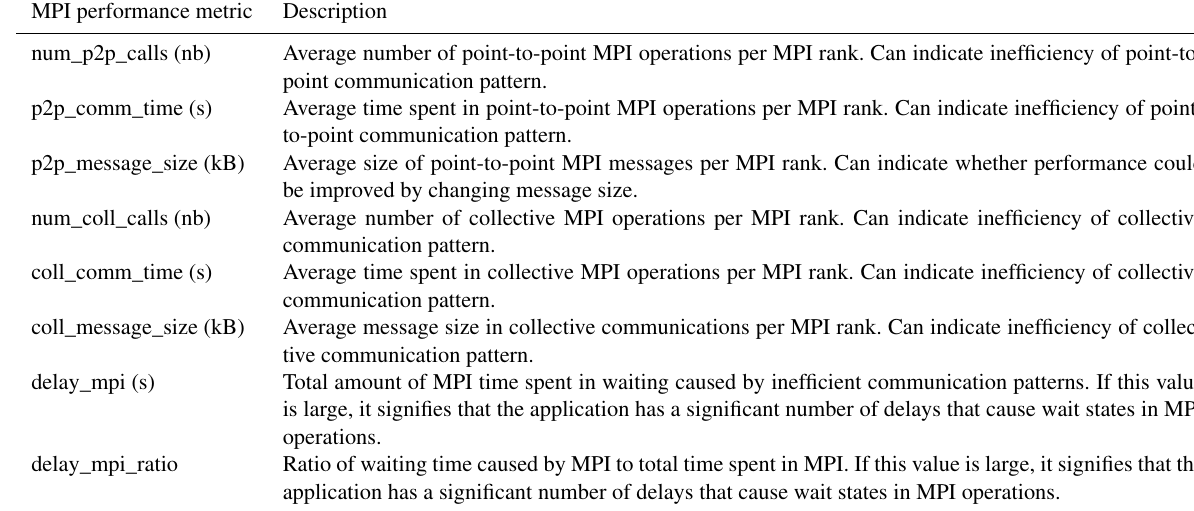
Table B3. Description of performance analysis metrics pertaining to MPI communication, currently supported by our RCF. MPI performance metric